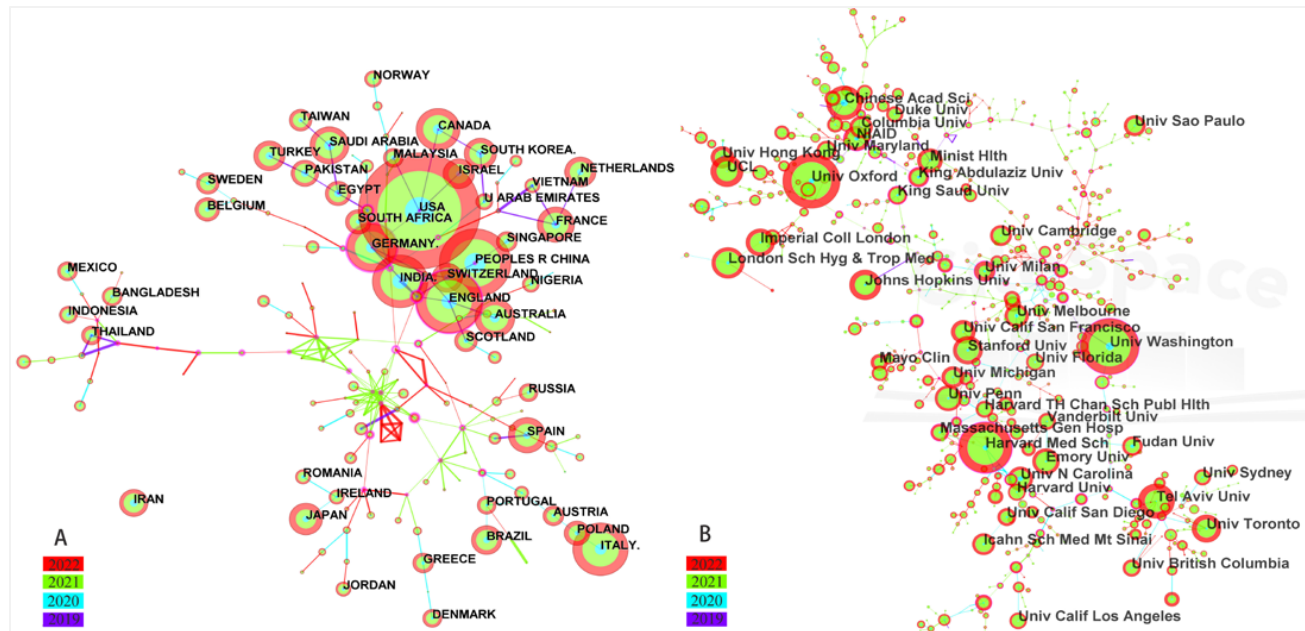
Figure 3. The countries’ ( A ) and institutions’ ( B ) co-authorship network visualization map in COVID-19 vaccine research. The CiteSpace software was used to analyze information about co-authorship countries and institutions. The selection criterion was that the g-index was 25 in each slice. The USA was the most productive country ( n = 5711 ). It was one of the leading coun- tries with the largest network of international cooperation in COVID-19 vaccine research. The UK ( n = 2020) ranked second, and third was China ( n = 1819), in the number of pub- lished documents. According to publication and centrality (Table 1), the USA, UK, and